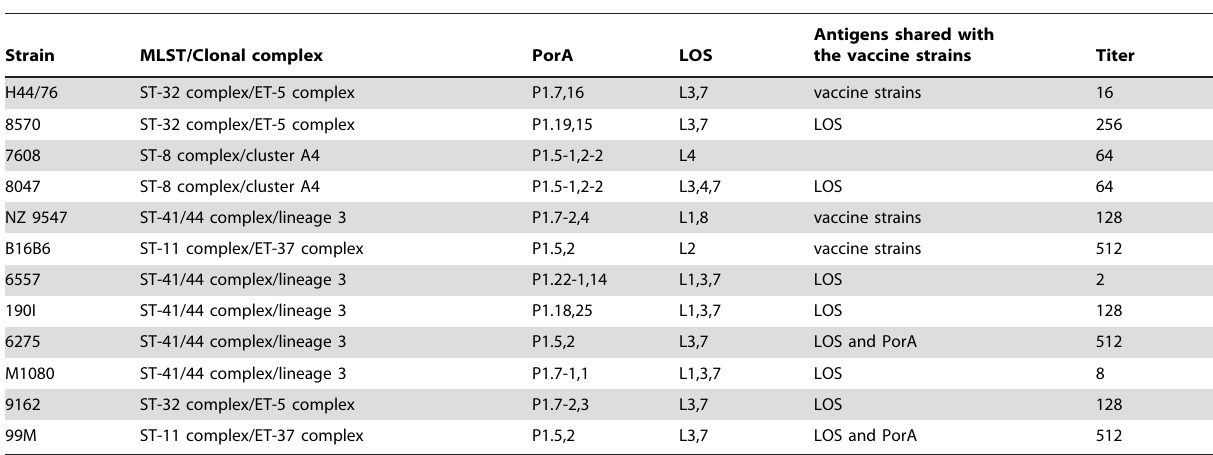
Table 1. Bactericidal activity against serogroup B N. meningitidis strains.